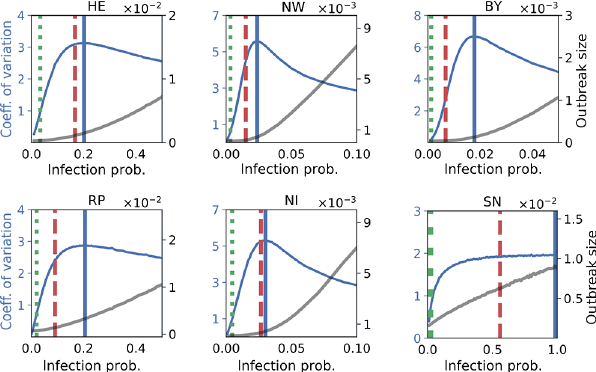
FIG. 8. Detailed threshold analysis for six selected federal states with μ ¼ 1 = 28 (cf. Table I). We show the simulated mean outbreak size (grey line, right axis) and coefficient of variation (blue line, left axis) averaged over all initially infected nodes. The critical infection probability from MC simulations are shown, and the IB and CB models are presented as vertical blue, green dotted, and red dashed lines, respectively.